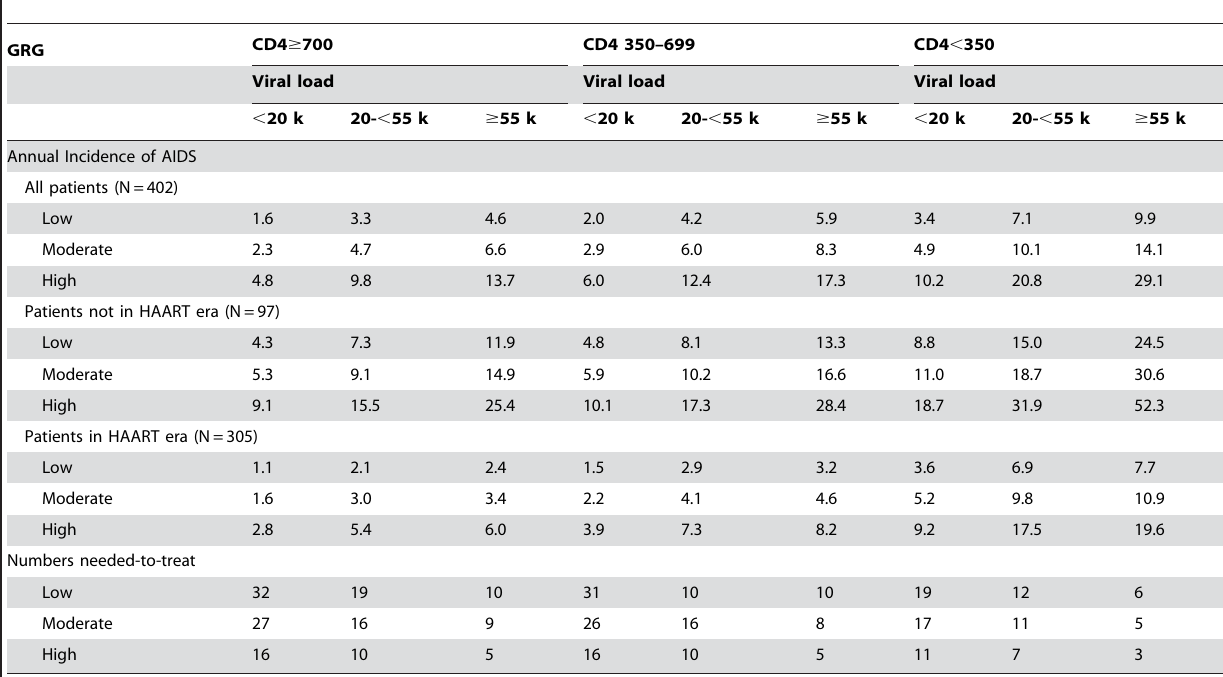
Table 2. Annual incidence of AIDS (%) and numbers needed-to-treat according to baseline CD4 + T cell count, the steady-state viral load and CCL3L1-CCR5 GRG, based on Poisson regression